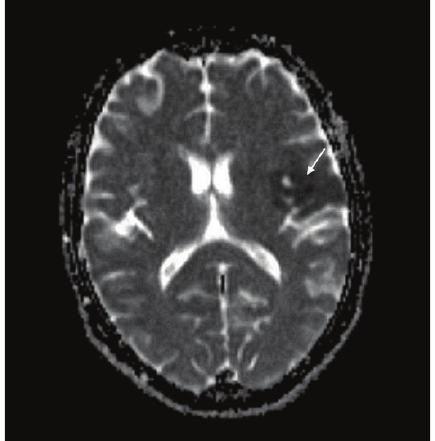
Figure 3: Axial ADC-MRI scan demonstrating low intensity lesion at the left frontal region consistent with acute infarction.